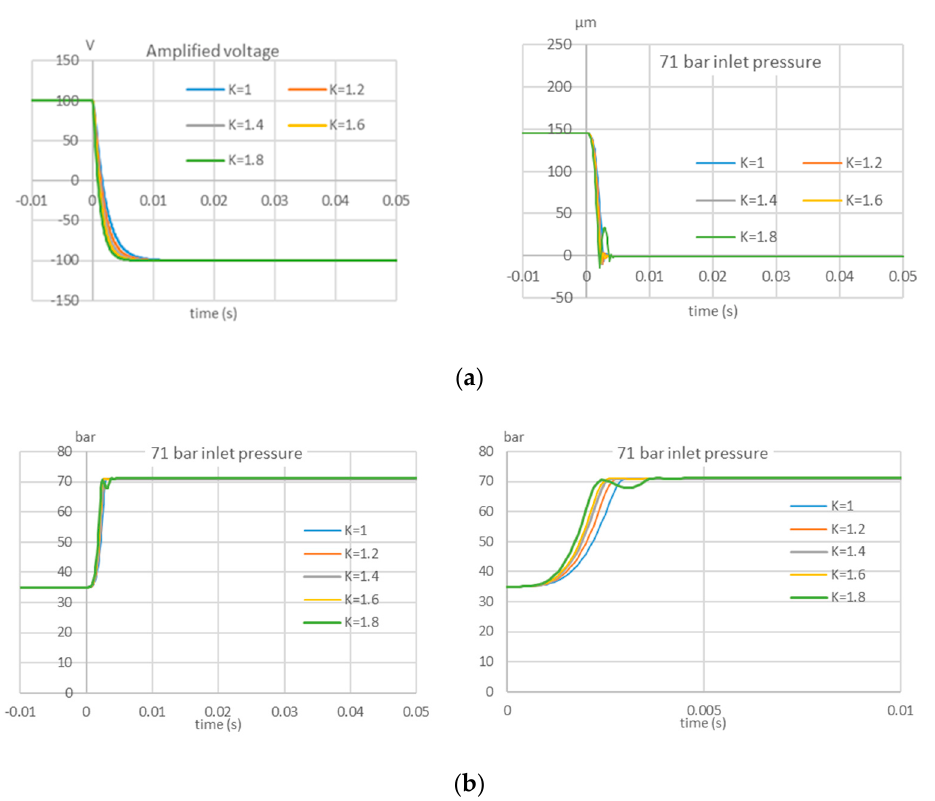
Figure 16. Amplified voltage and ring bender displacement ( a ) and pressure at point 7 with enlargement ( b ), simulated for an amplified voltage from + 100 V to − 100 V and for di ff erent values of the natural frequency of the amplifier: ω n = k ω n , o with K = 1, 1.2, 1.4, 1.6, 1.8 (supply pressure = 71 bar, D = 0.6 D 0 and L = 0.6 L 0 , m = 0.6 m 0 ).